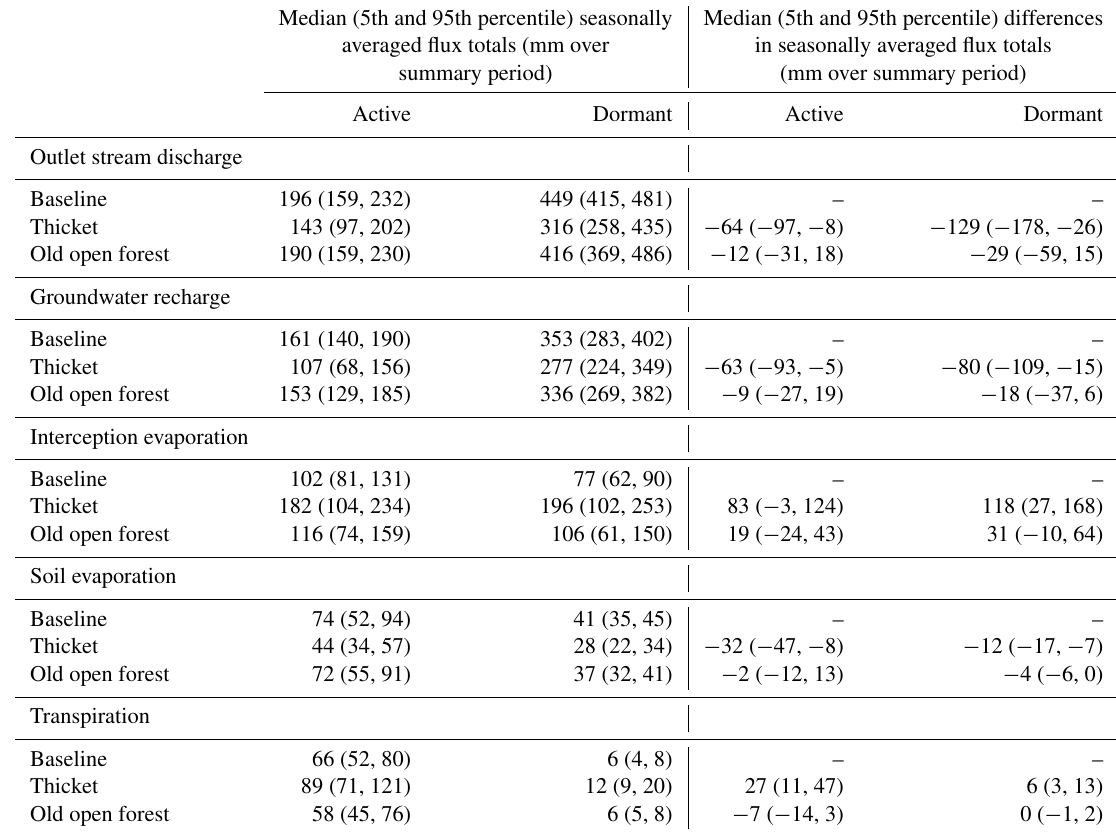
Table 3. Seasonally averaged water flux totals and differences in seasonally averaged totals. Totals and differences were calculated for each behavioural run individually and summarised by the median and 5th and 95th percentile (in parentheses) values across all behavioural runs. Differences are reported as the regeneration scenario minus baseline and help to indicate whether the simulated direction of change in each flux was consistent among behavioural models. Active and dormant seasons cover April to September and October to March, respectively. Median (5th and 95th percentile)